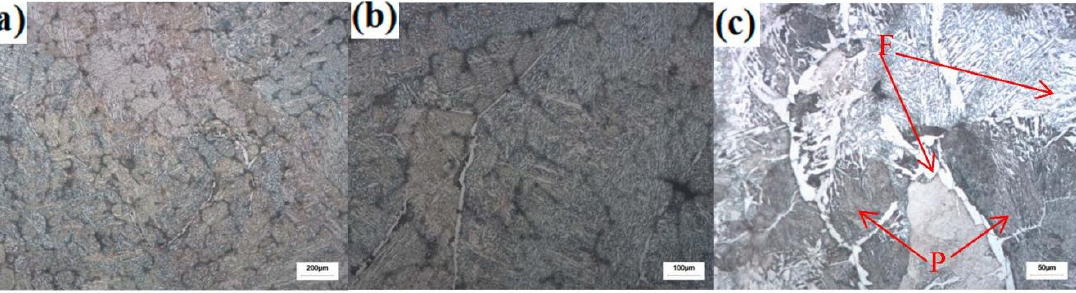
Figure 11. Microstructure of 2# as-cast tested steel (( a , b , c ) represent 50×, 100× and 200×, respectively).